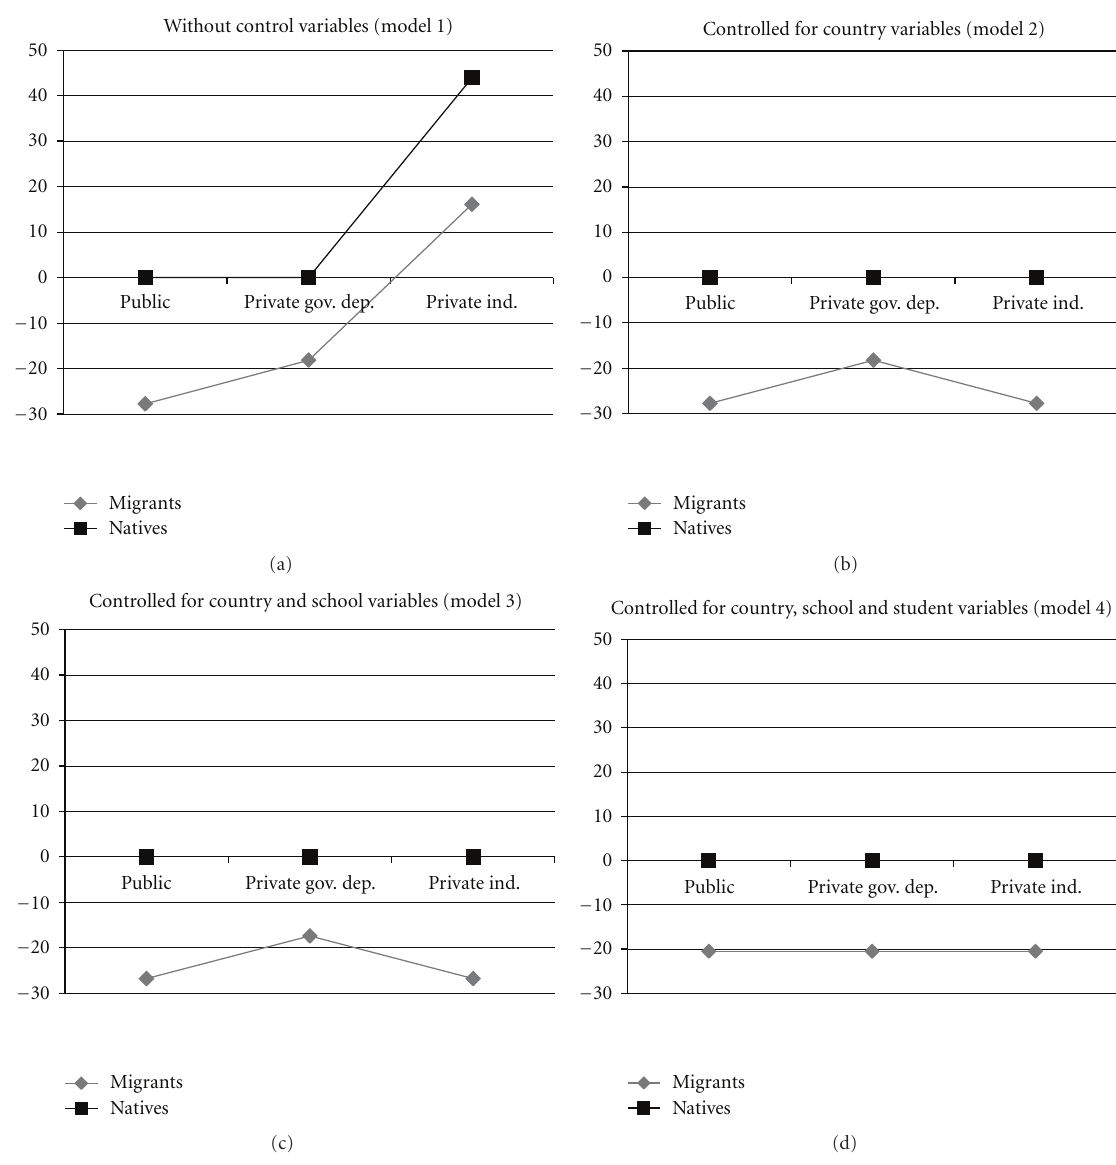
Figure 2: E ff ects of migration status and school type on reading